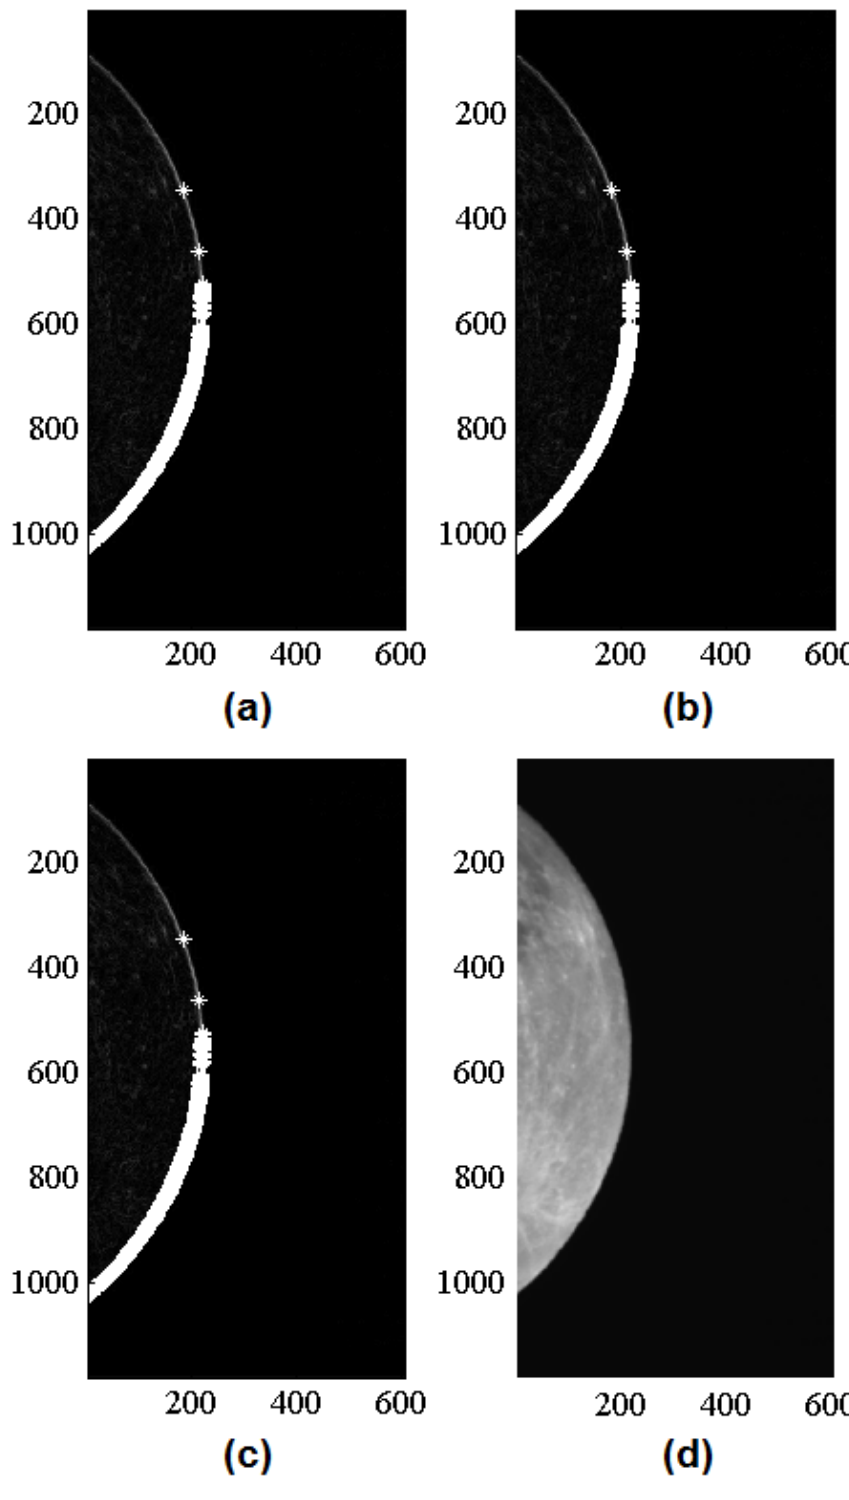
Figure 16. Example 3: Image processing phases (data in pixel). ( a ) 1500 highest derivatives; ( b ) 21 × 21 box approach removed 35 outliers; ( c ) RANSAC removed 0 outliers using 100 = 4 ; ( d ) Body center outside image. Row center = 551.8926, Column center tests and d min = − 393.0706, Radius = 612.8029 (worst residual =